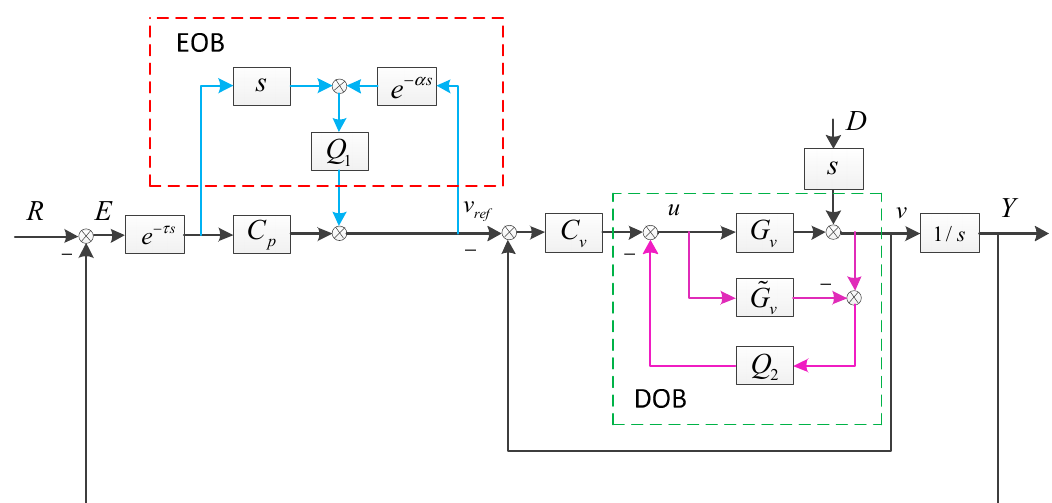
G  refers to the approximate velocity v